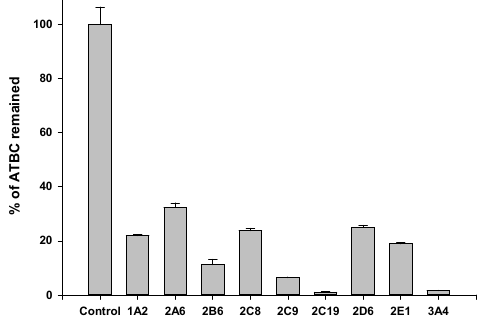
Figure 5. Metabolic stability of ATBC in human recombinant CYP supersomes. Data were expressed as mean ± SD ( n = 3). ATBC was tested at 10 μM. Control: blank incubation matrix (all except for CYPs).